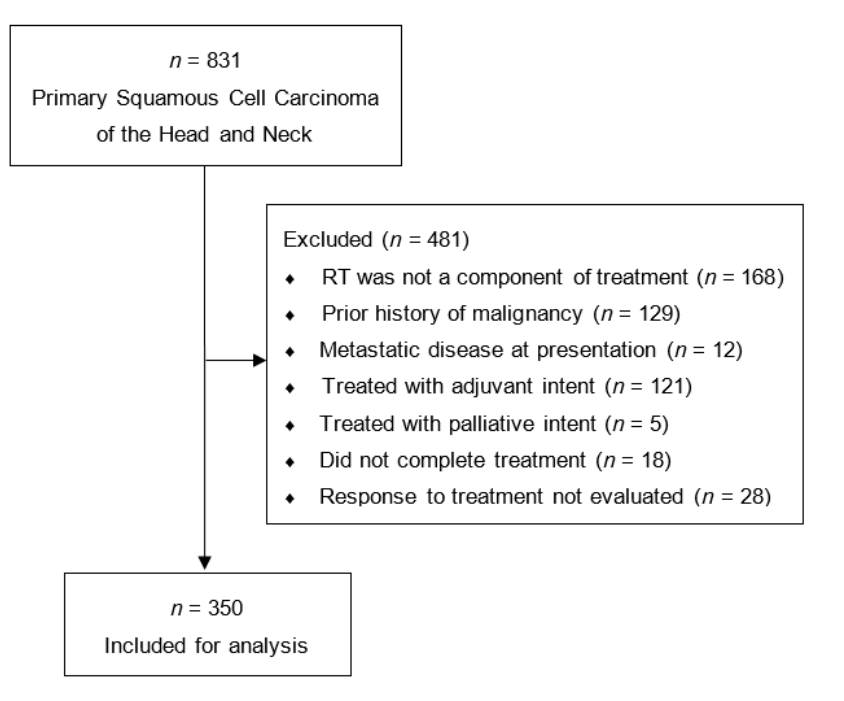
Figure 1. Patient selection criteria.